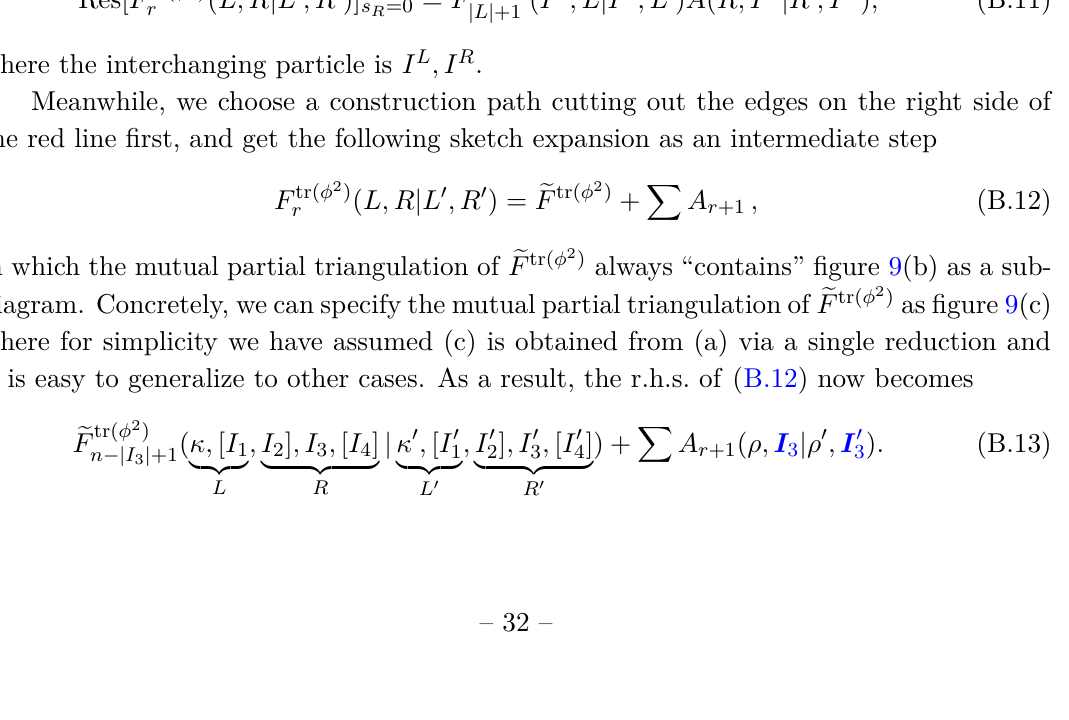
and s 1 , 2 , 3 4 , 5 , 6